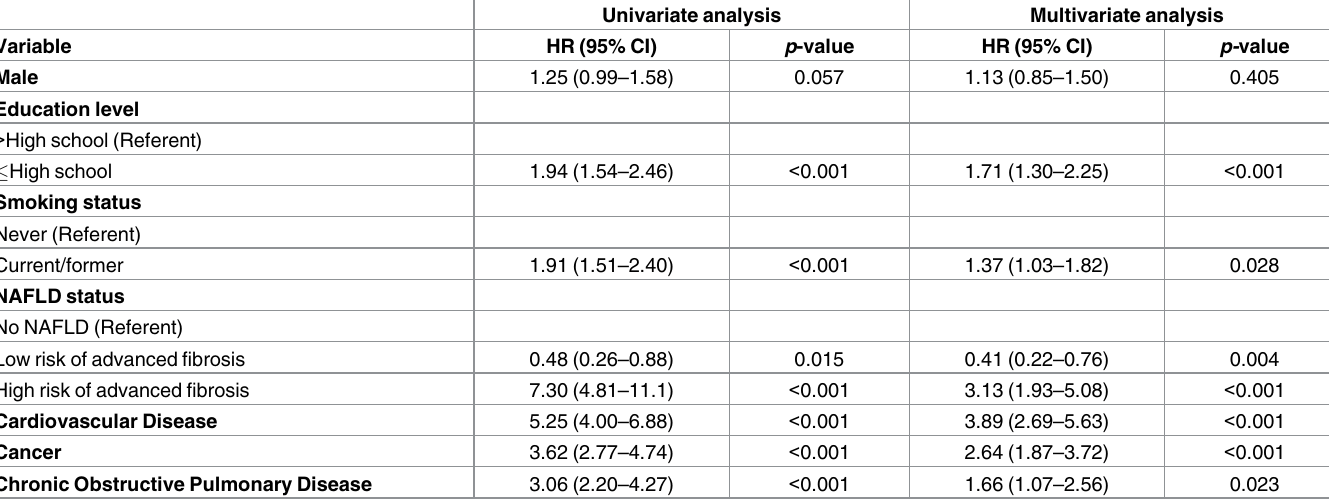
Table 4. Risk factors for overall mortality in the U.S. National Health and Nutrition Examination Survey, 1999–2010 (n =